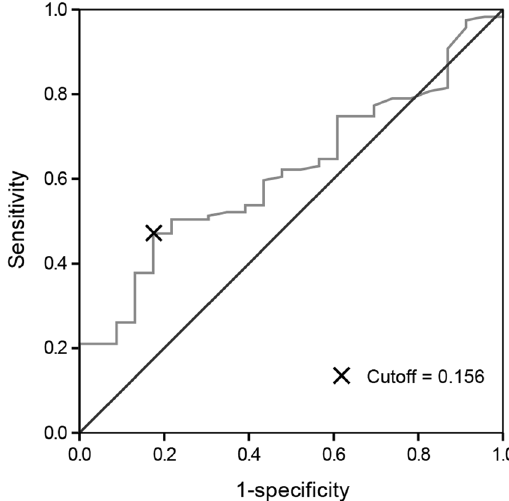
Figure 1. Cutoff value of CAR assessed by ROC